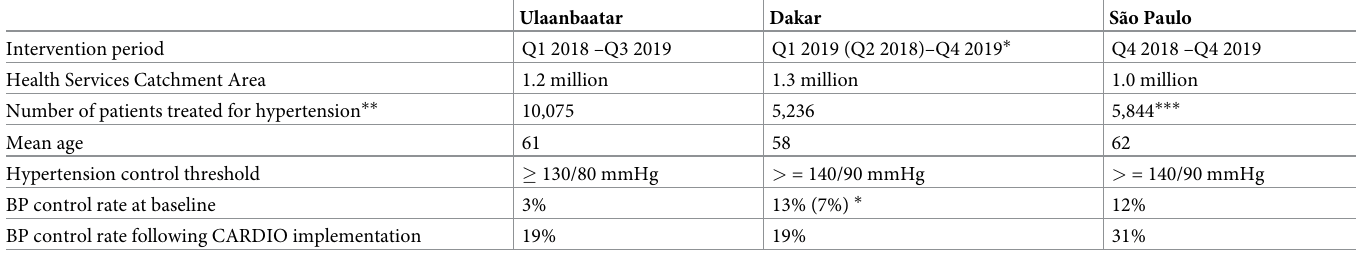
Table 1. Patient characteristics and outcomes. This table summarizes previously published population characteristics, intervention periods, and differences in hyperten- sion control rates following the implementation of the CARDIO4Cities approach in Ulaanbaatar, Dakar, and S ã o